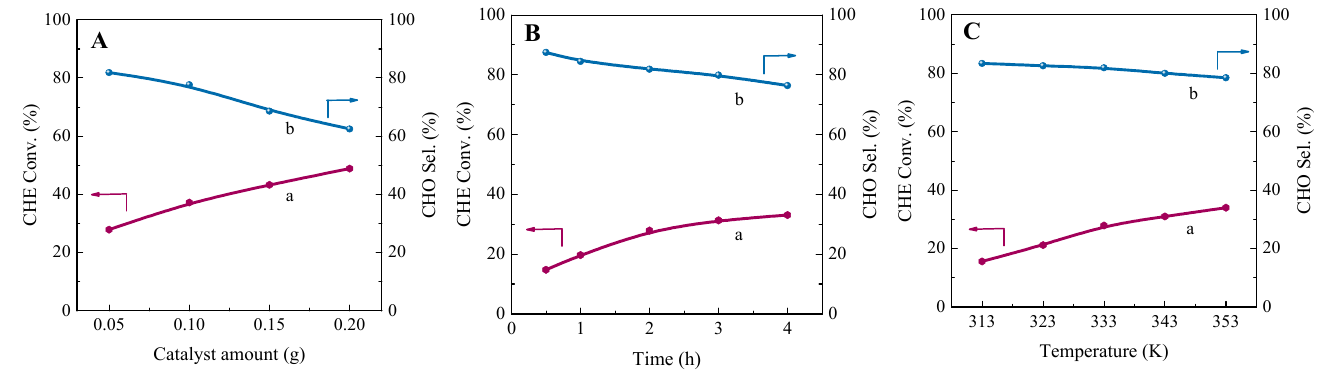
Figure 11. Dependence of CHE conversion (a) and CHO selectivity (b) on the catalyst amount ( A ), reaction time ( B ) and reaction temperatures ( C ) over Re − Ti − Beta − 0.20. Reaction conditions: CHE, 10 mmol; H 2 O 2 (30 wt.%), 10 mmol; MeCN, 10 mL.